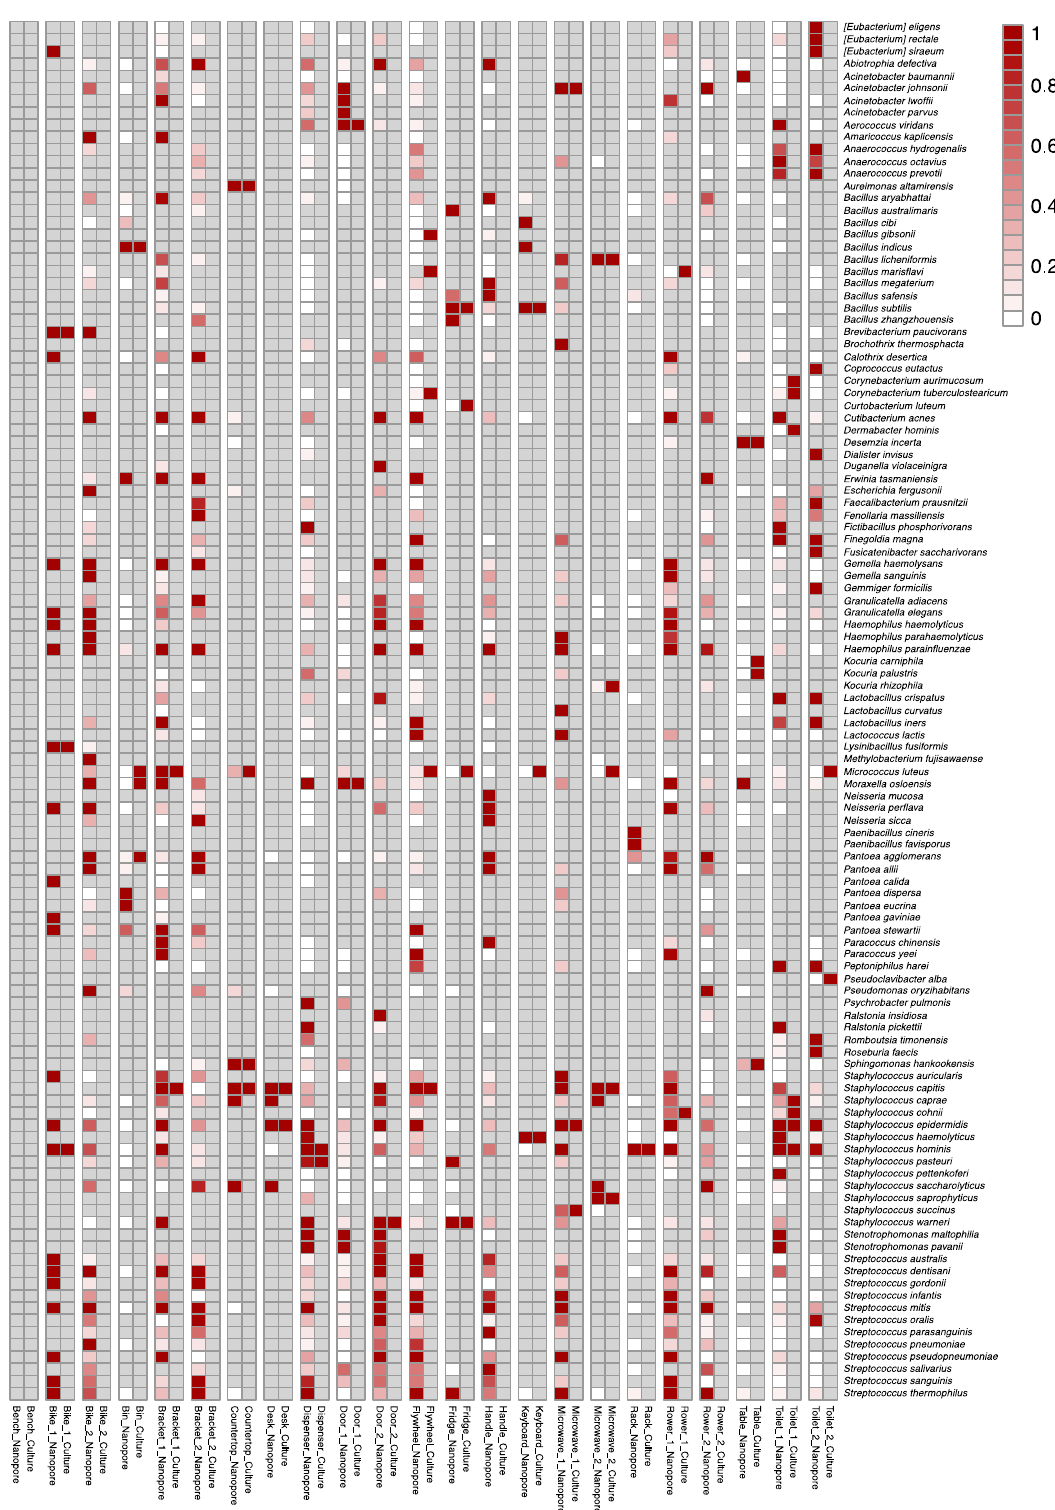
Figure 2. Heatmap of the relative abundance for bacterial species identified using a culture-dependent method as compared to the culture-independent, swab-to-sequencer method. Species less than 0.05% in abundance were excluded. Least abundant to the most abundant is represented from white to dark red with gray as zero abundance. Relative abundance of culture-based isolates was calculated from the colony forming units (CFU). Sample locations referred to in Supplementary Table S2 for more details.